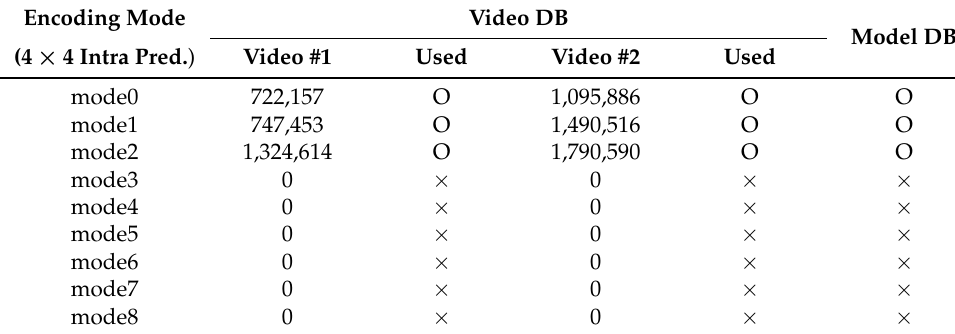
Table 6. Example of 4 × 4 intra prediction in H.264. Here, descriptors from two videos shot by the same camera are identical to each other. Here, O and × represent ‘used’ and ‘not used’, respectively.